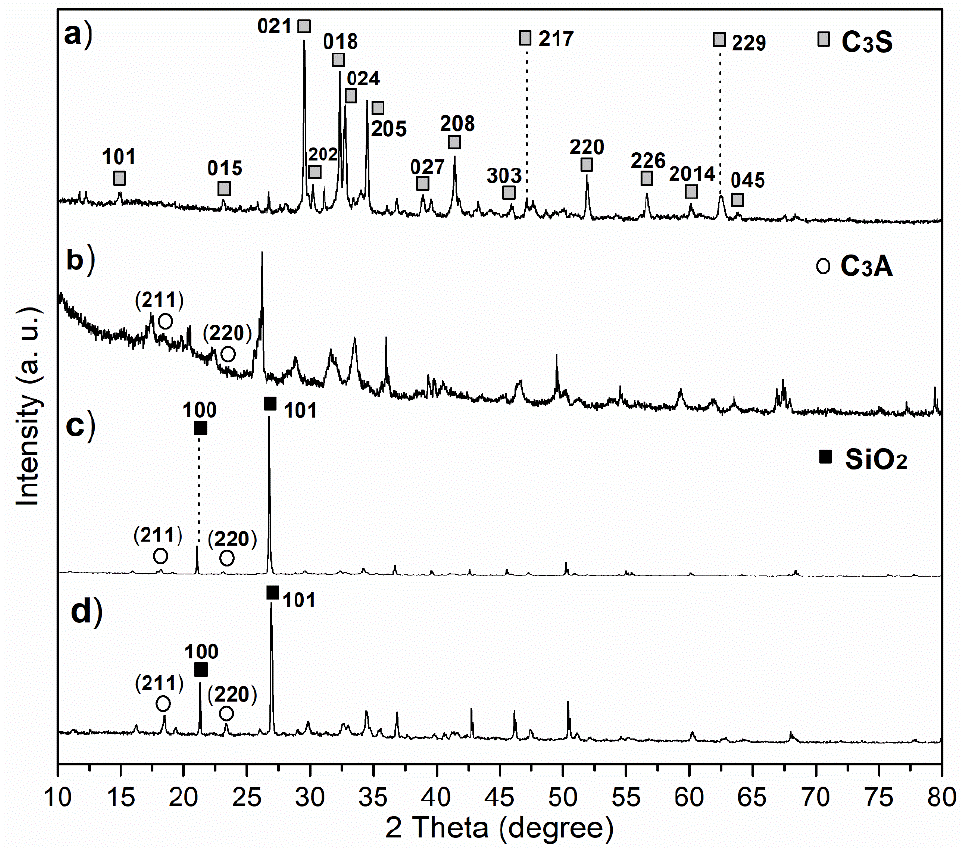
Figure 7. Wide-angle XRD patterns of the powdered samples: ( a ) Cement, ( b ) sample 2, ( c ) sample 7, and ( d ) sample 10.